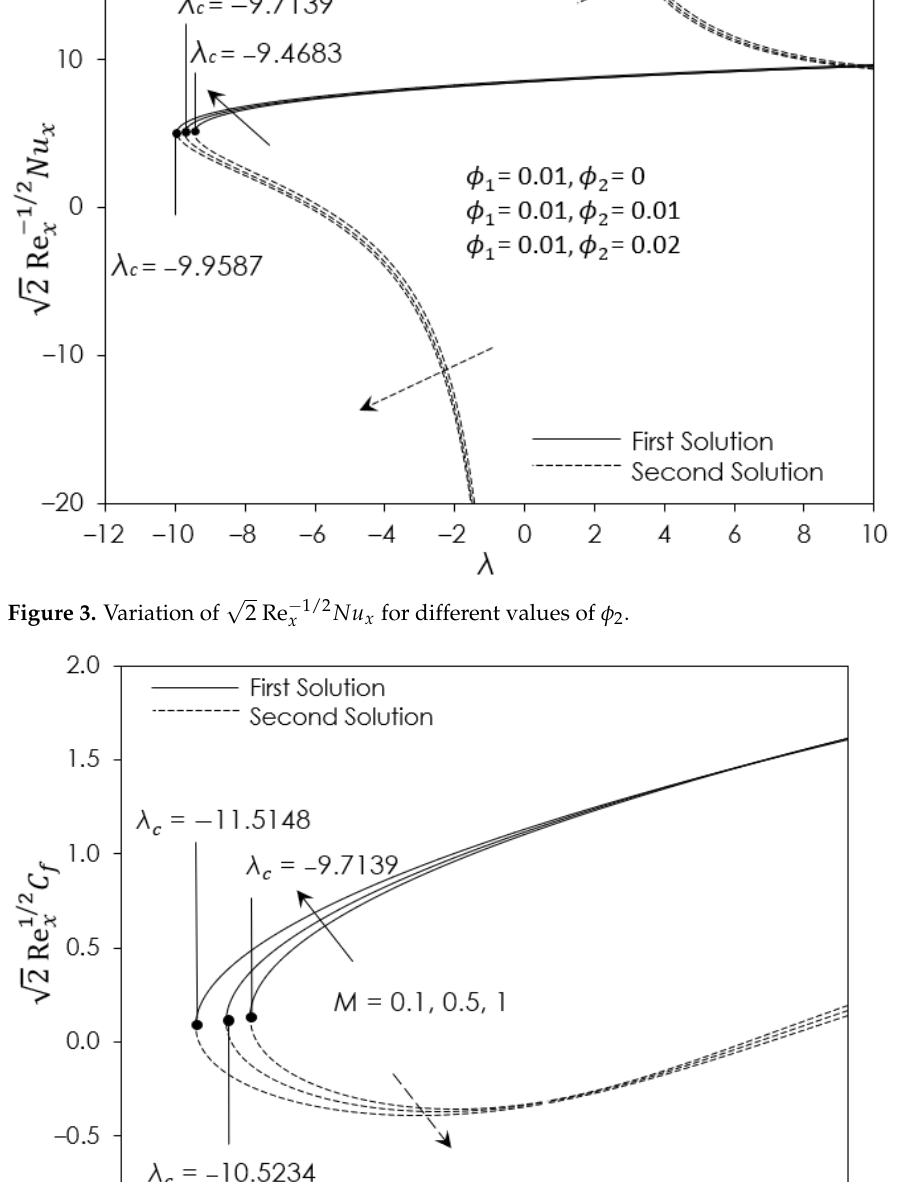
Figure 4. Variation of √2 Re 𝑥1/2 𝐶 𝑓 for different values of 𝑀 .